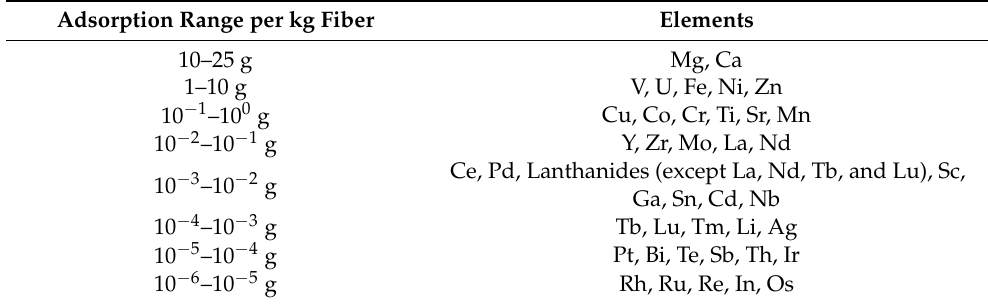
Table 1. Adsorption range of different elements by the amidoxime–carboxylate containing polymer fiber in Sequim Bay seawater after 56 days of exposure at 20 ◦ C.